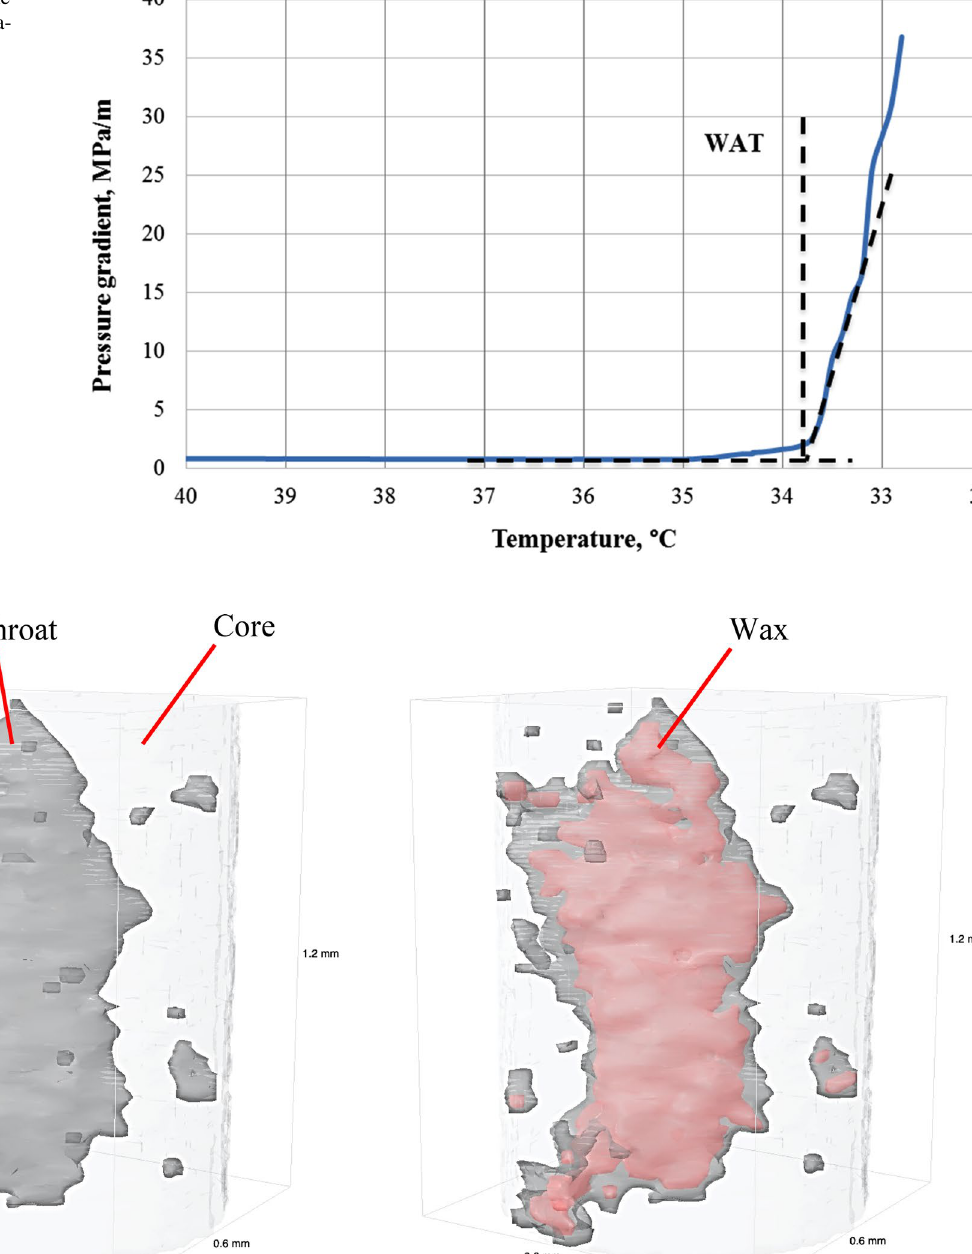
Fig. 4 The dependence of the pressure gradient on tempera- ture